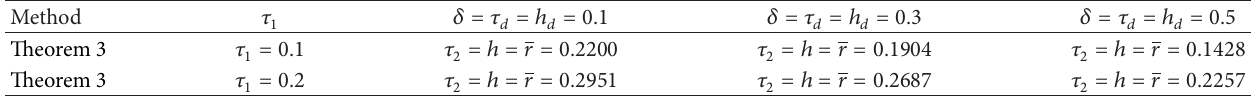
Table 1: Allowable upper bound 𝜏 2 = ℎ = 𝑟 for different 𝛿 = 𝜏 𝑑 = ℎ 𝑑 .